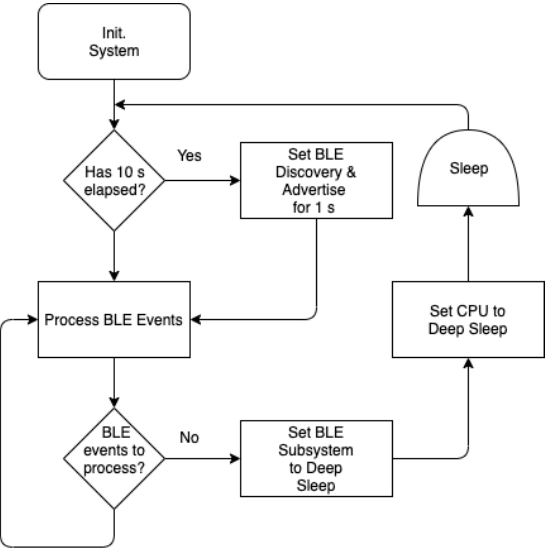
Figure 7. Improved system flow